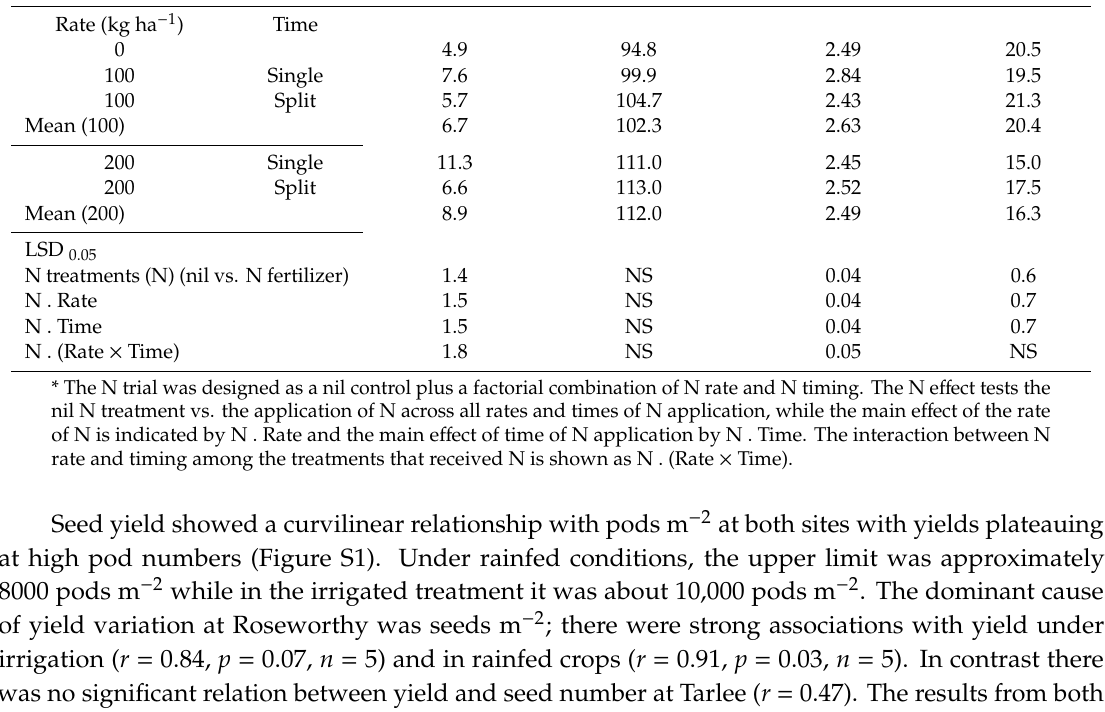
Table 5. E ff ect of di ff erent N applications on yield components of rainfed canola at Tarlee site *. N Treatments